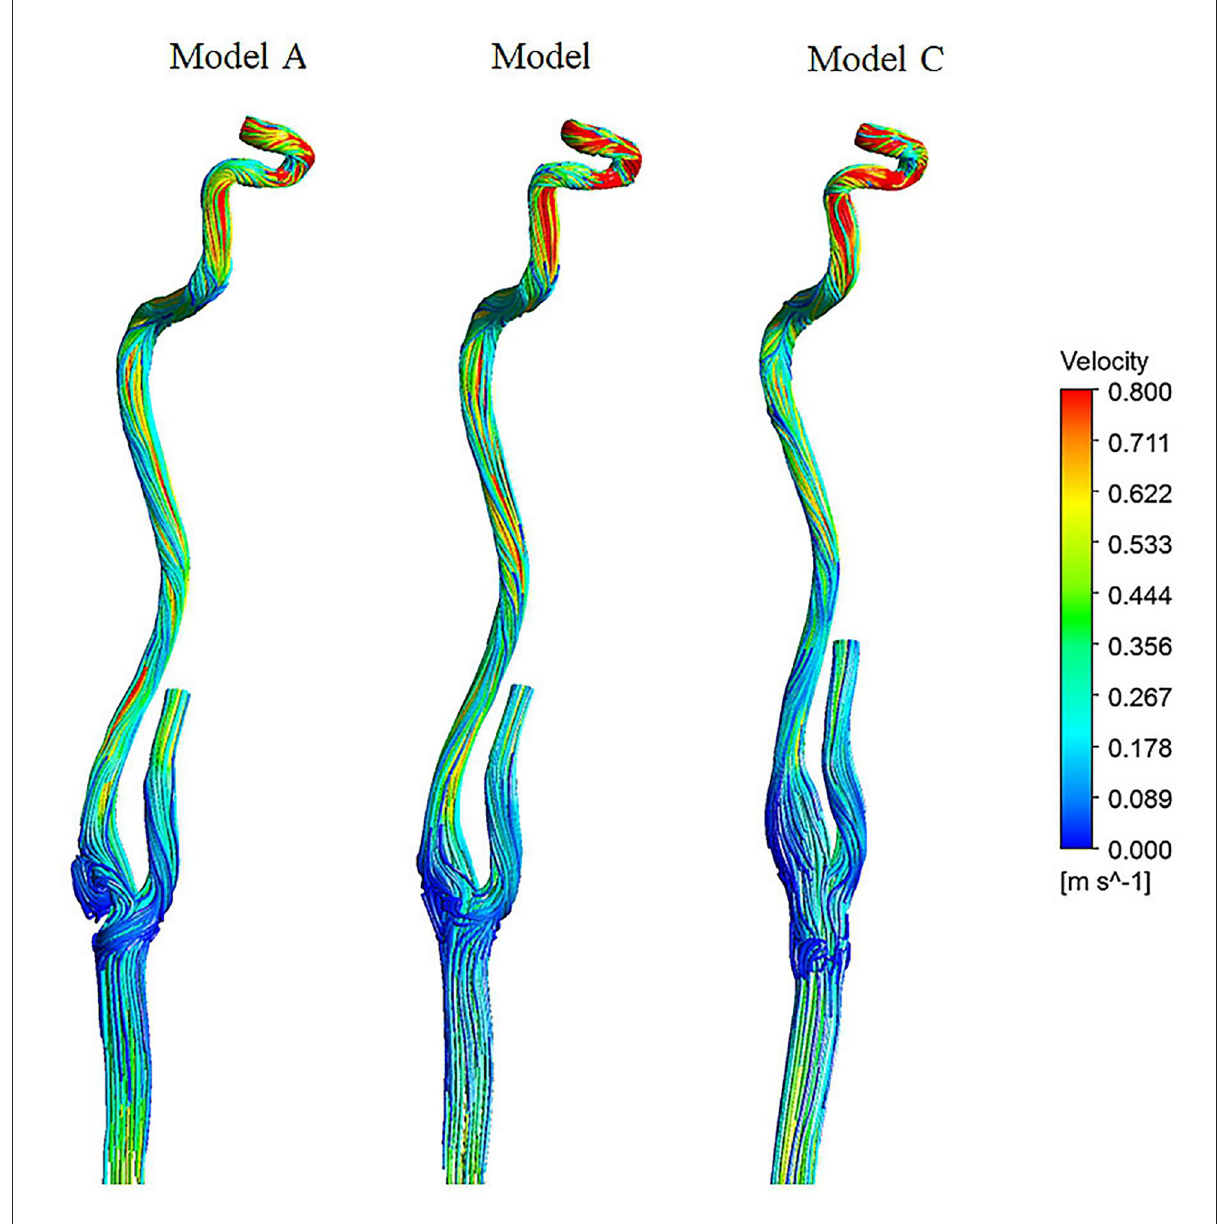
FIGURE3 Streamlines colored by the magnitude of velocity at peak